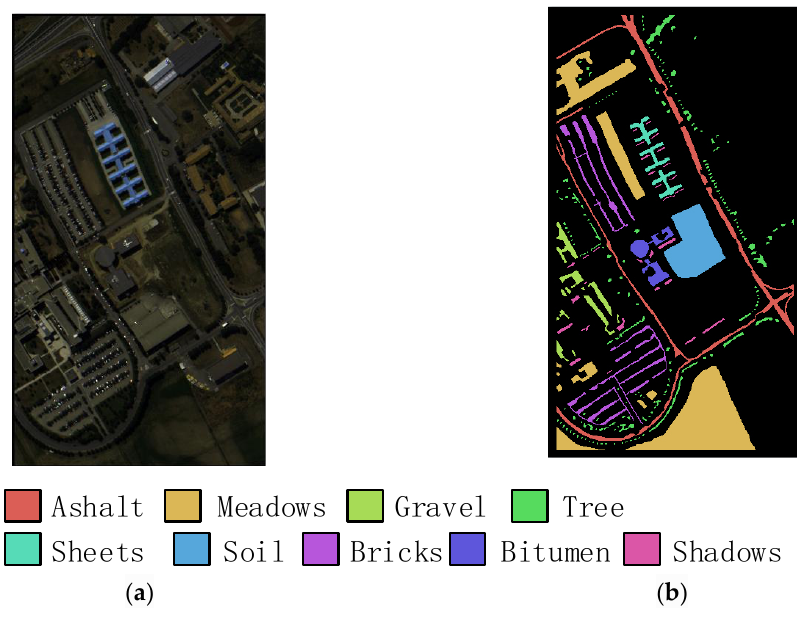
Figure 6. Pavia University dataset, ( a ) original image, ( b ) mark map of real ground objects. Table 1. Training validation and testing sample numbers for the Pavia University dataset.